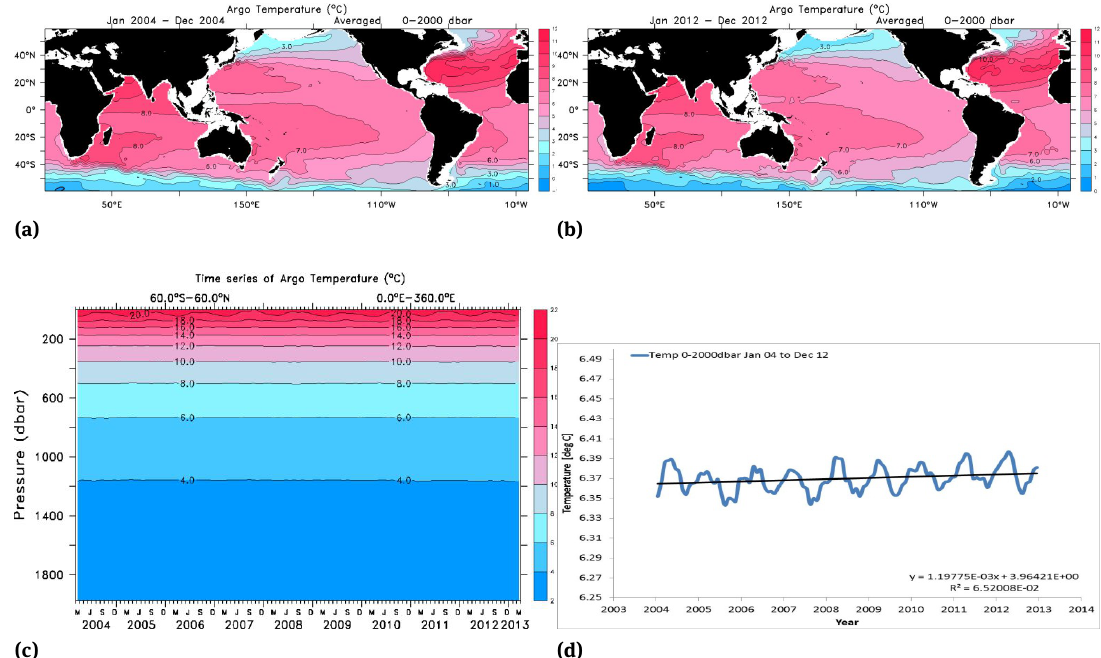
Fig. 2. a, b: yearly averaged constant temperature lines over the years 2004 and 2012 in the layer 0 – 2000 meters; c: temperature time se- ries March 2004 to March 2013; d: trend line for temperatures in the layer 0-2000m. Figures are obtained by using the ARGO Global Marine Atlas (from ARGO [6]).